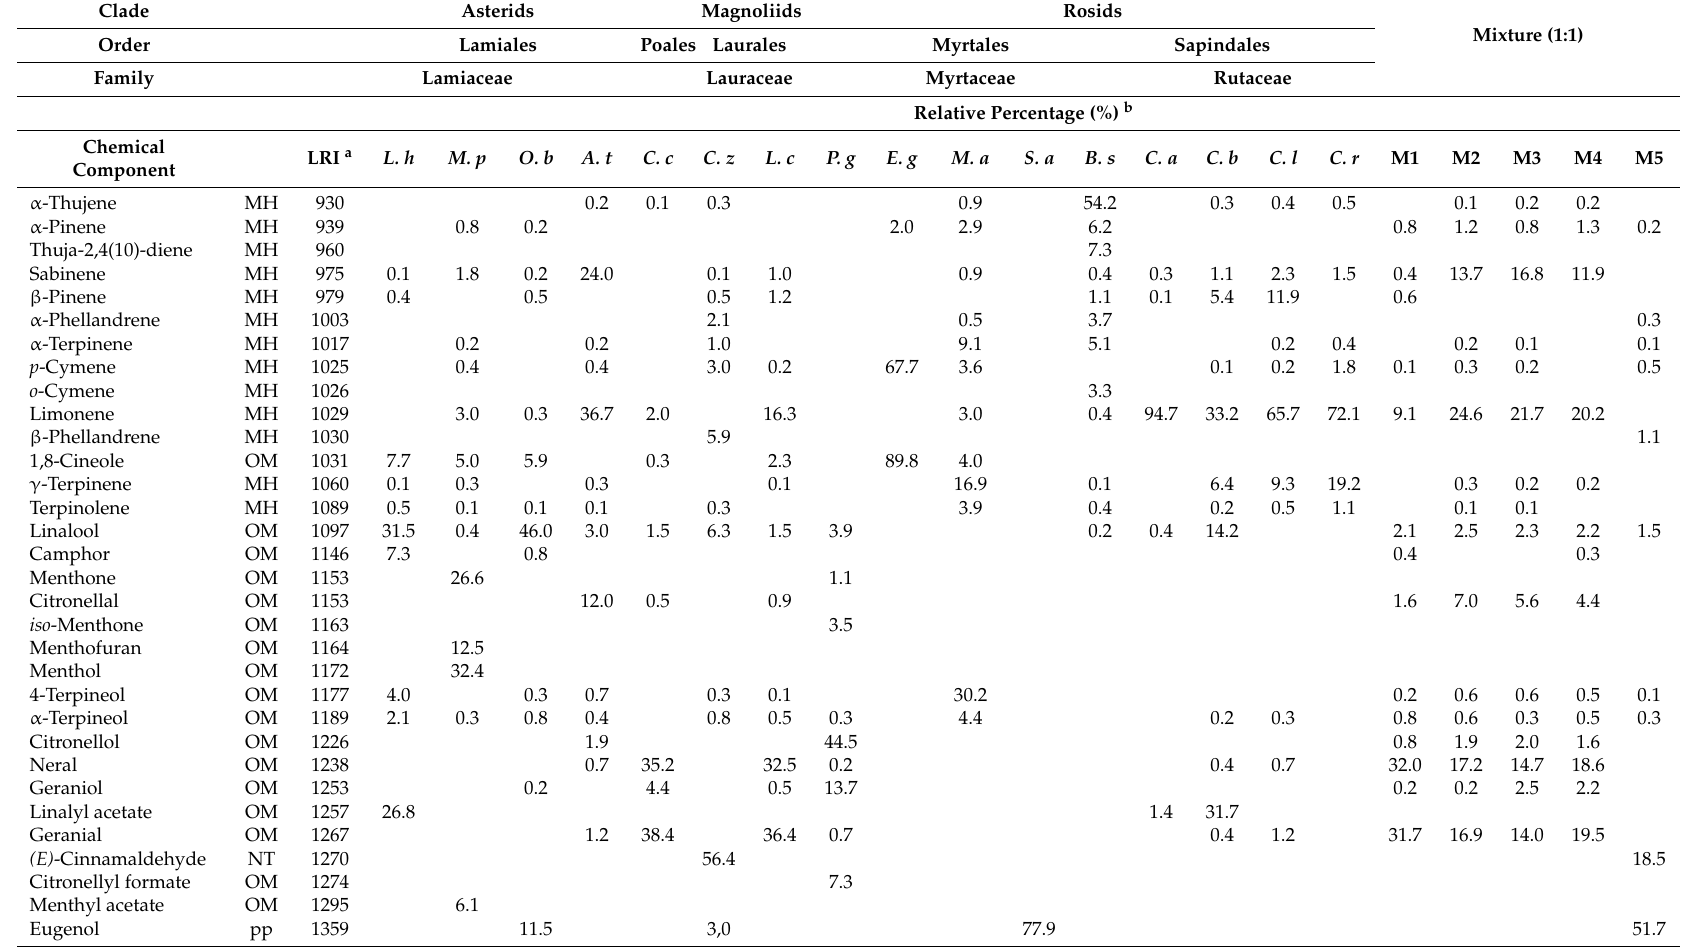
Table 1. Chemical composition of tested